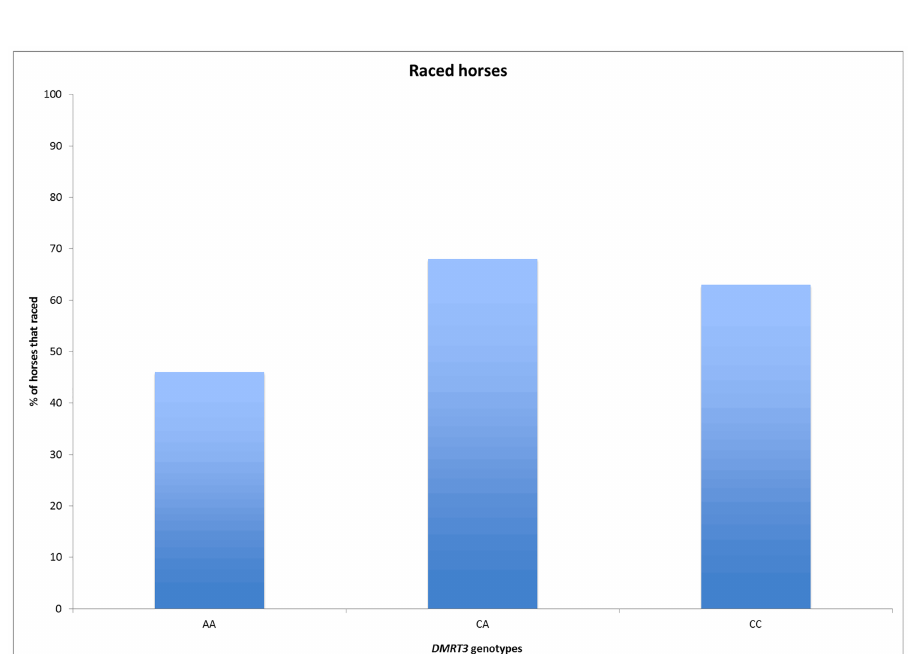
Fig 3. Percentage of raced horses for each DMRT3 genotype.